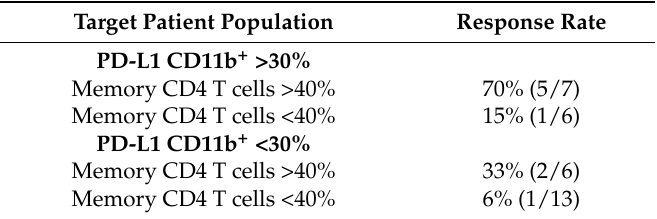
Table 2. Patient stratification according to PD-L1 expression in myeloid cells combined with memory CD4 T cell profile and associated response